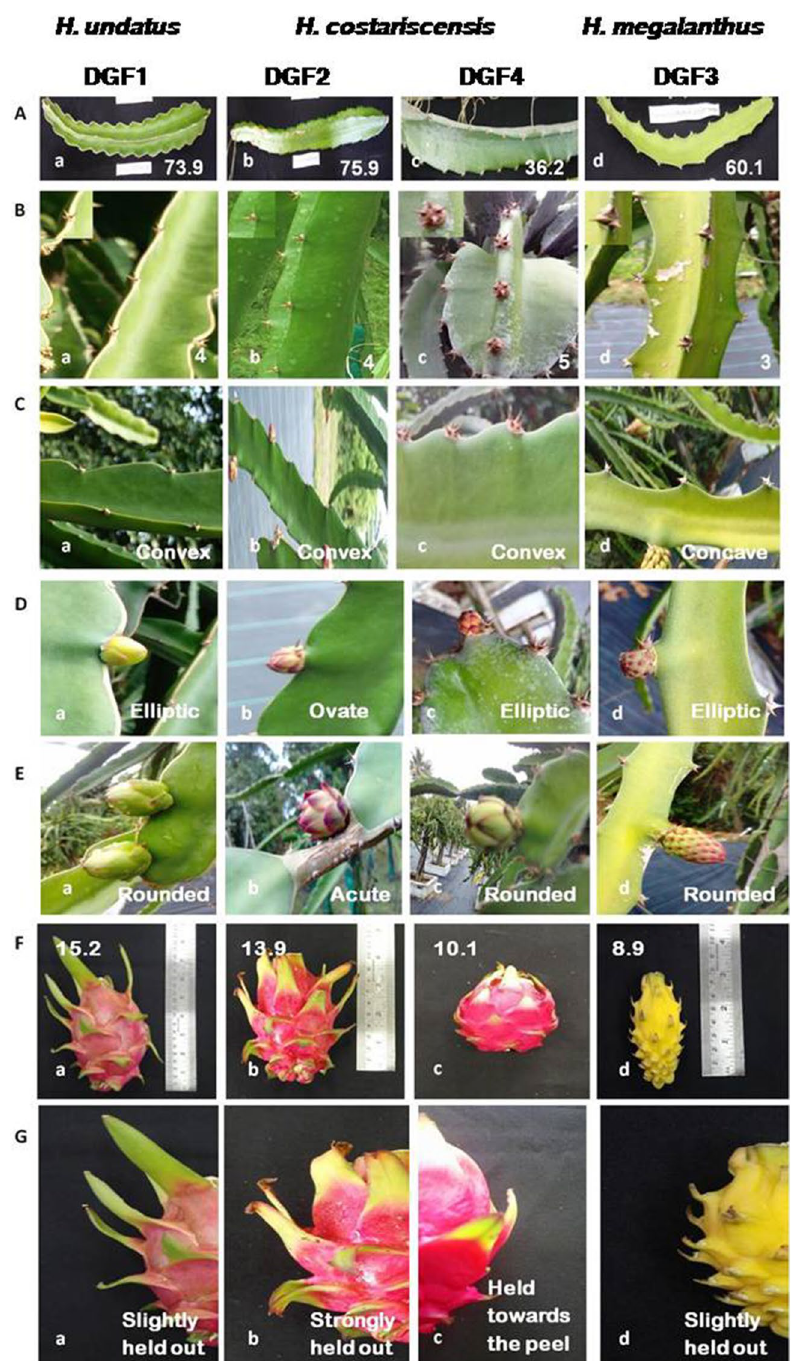
Figure 2. An illustration of important traits of three different Hylocereus species of dragon fruit. Cladode characters: ( A ) length of segments (cm), ( B ) number of spines and ( C ) margin ribs of cladode; Flower characters: ( D ) flower bud shape and ( E ) shape of apex; fruit characters: ( F ) fruit length (cm) and ( G ) position towards the